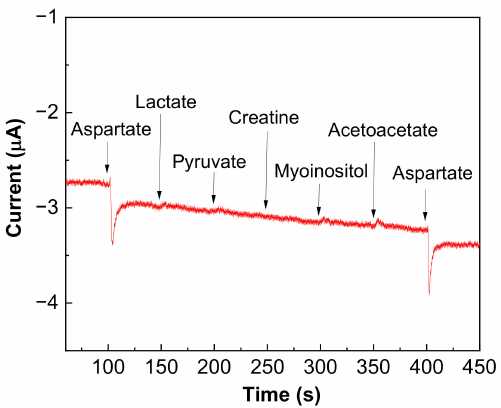
Figure 6. CA results of GluOx–ASTENs/PB/SPCE in 50 mM buffer (pH 6.0) at − 0.1 V, with the additions of 0.8 mM Asp, lactate, pyruvate, creatine, myoinositol, and acetoacetate in the presence of 150 µ M α